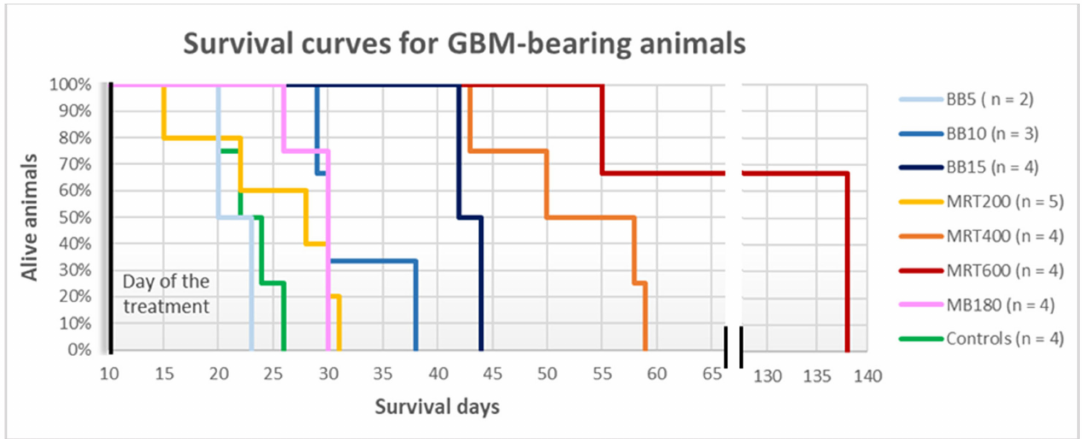
Figure 4. Survival curves of glioblastoma-bearing rats. The curves for the different irradiation groups are given as a percentage of surviving rats as a function of the survival days, counted from the glioblastoma implant